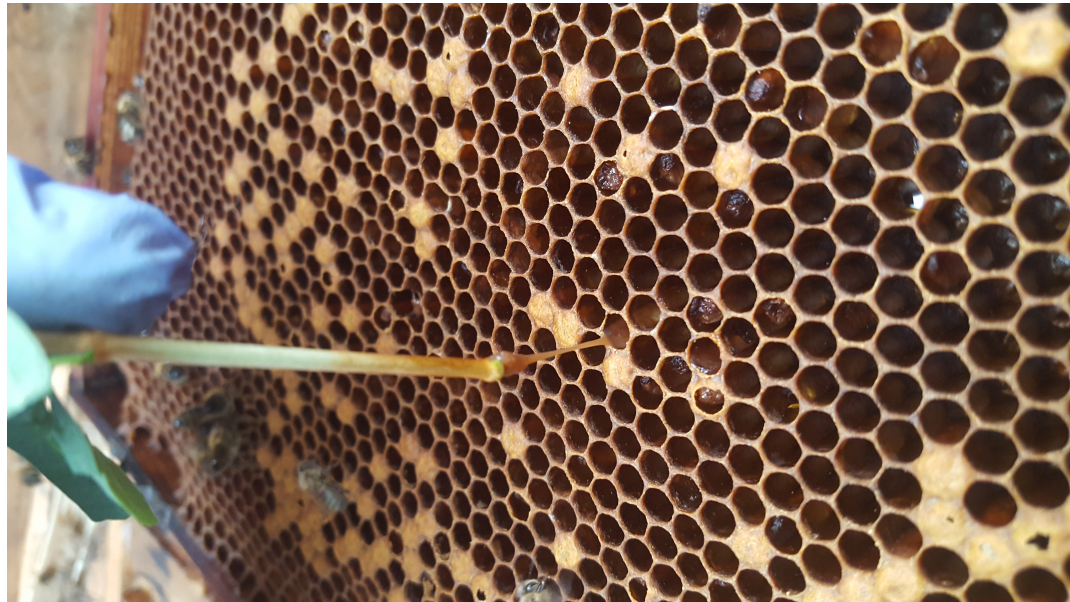
Figure 1. The bee comb with diseased brood for American foulbrood. Visible dragging rotten larvae, which emit a specific